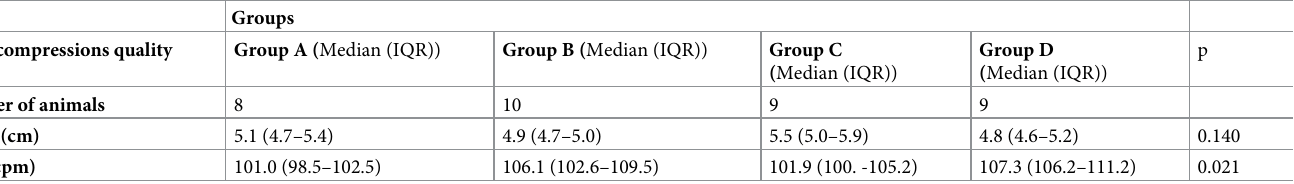
Table 4. Comparison of chest compression quality between